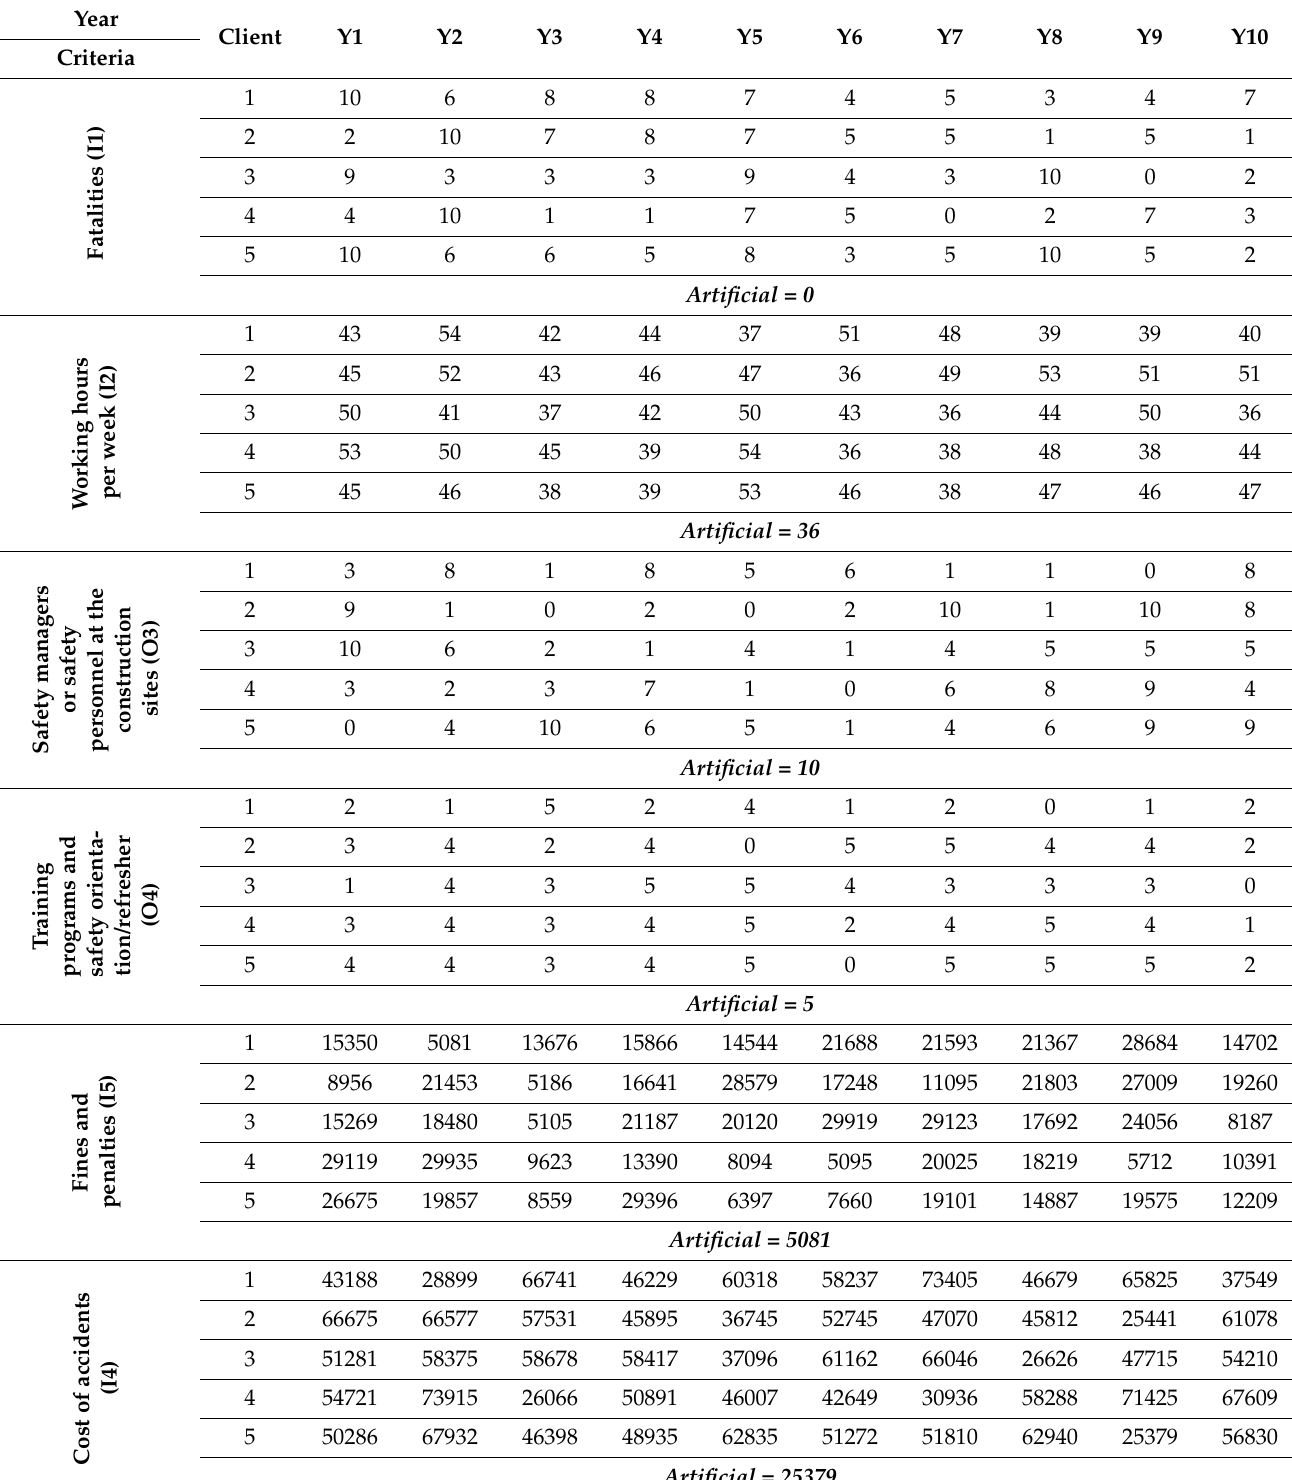
Table 2. The 10-year criteria values of an insurance company’s